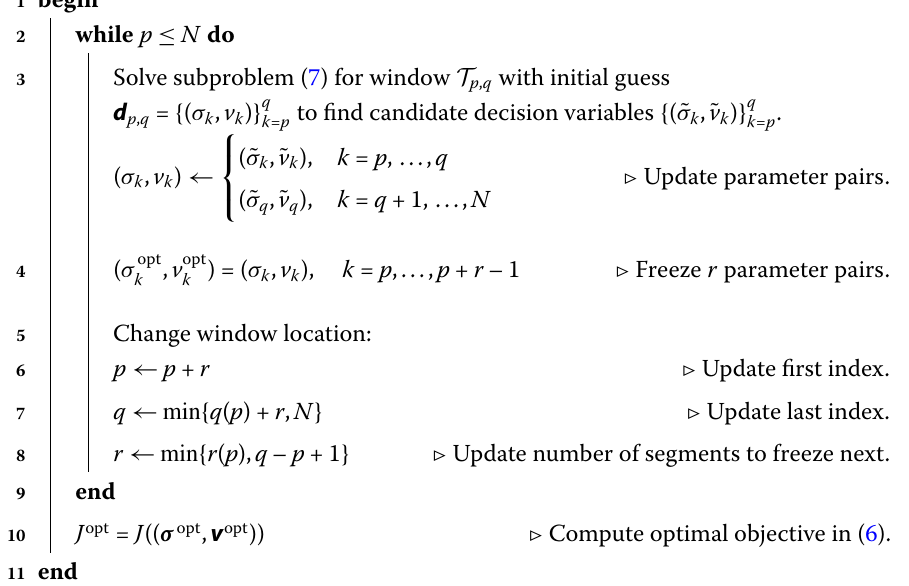
Algorithm 1: Greedy algorithm for finding an approximate solution of the scalarized problem (6). Note that q – p + 1 equals the size of the current